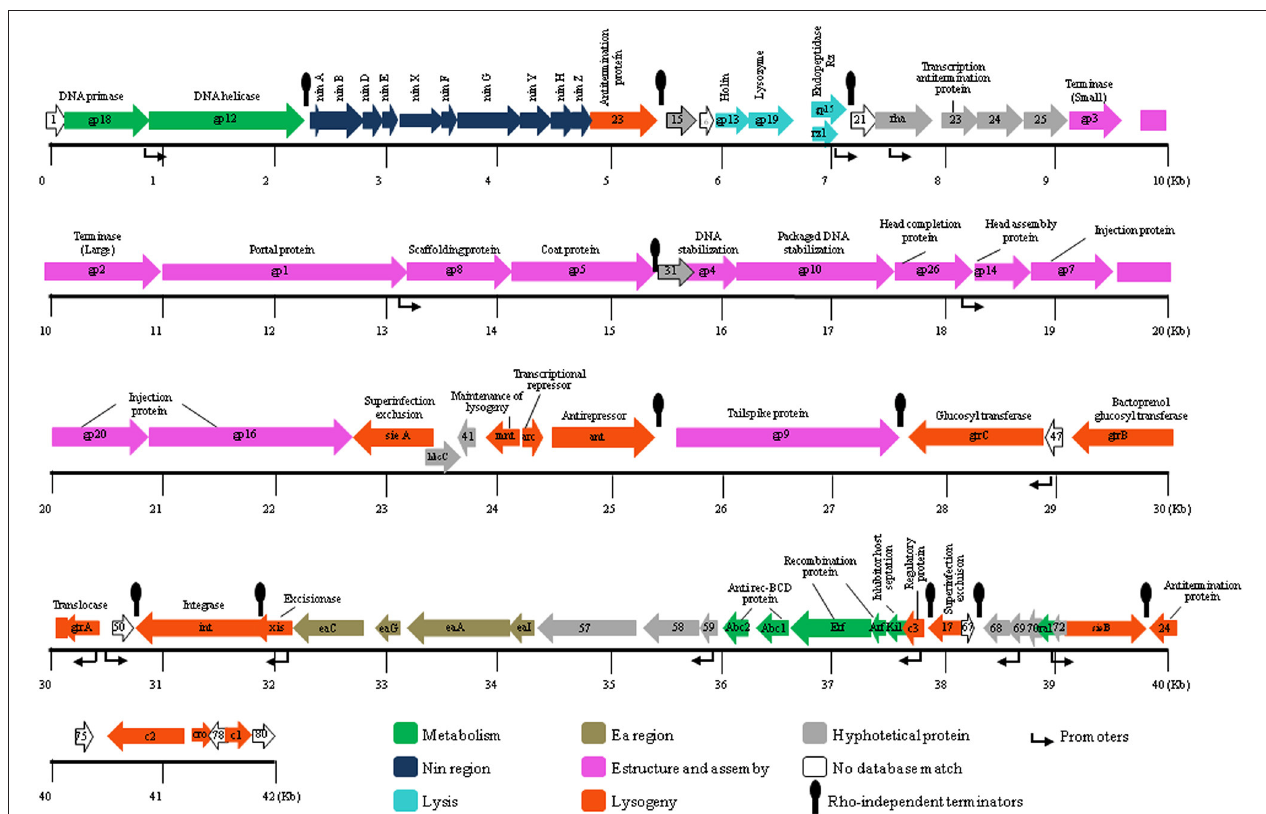
FIGURE 1 | Genomic structure of bacteriophage UAB_Phi20 including the Rho-indepedent terminators. Arrows represent genes, and the different colors identify the functional category into which the homologous genes were classified. Gene functions are indicated where they are known. The color code for gene function is provided at the bottom of the figure. ORFs are numbered consecutively from left to right as described in Table 1 , and are indicated by arrows pointing to the direction of